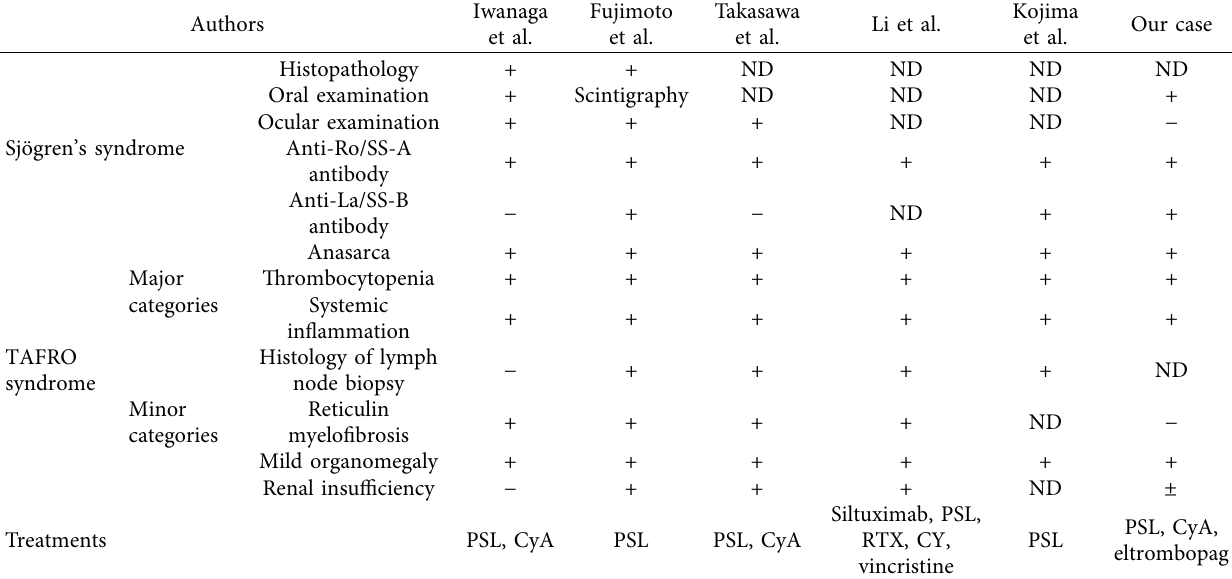
Table 2: Comparison summary of previous cases of Sj¨ogren’s syndrome complicated with clinicopathologic features of TAFRO syndrome.